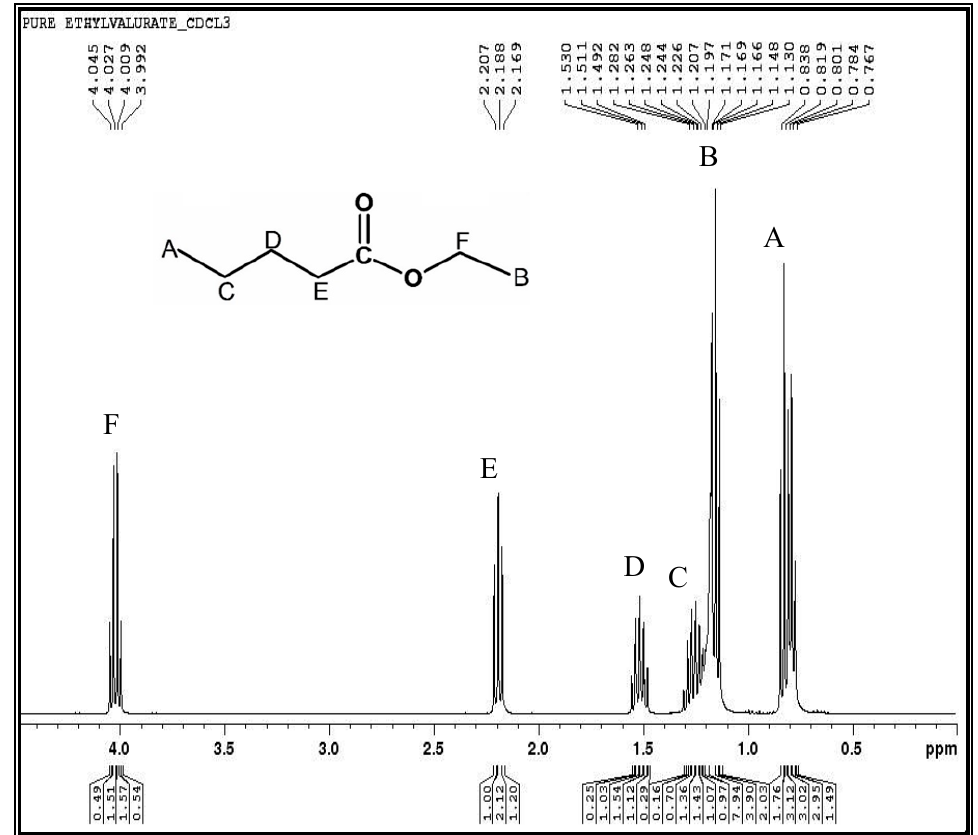
Figure 9. 1 H-NMR spectrum for the pure EV (valeric acid and ethanol molar ratio (1:2) at 3 h reaction).